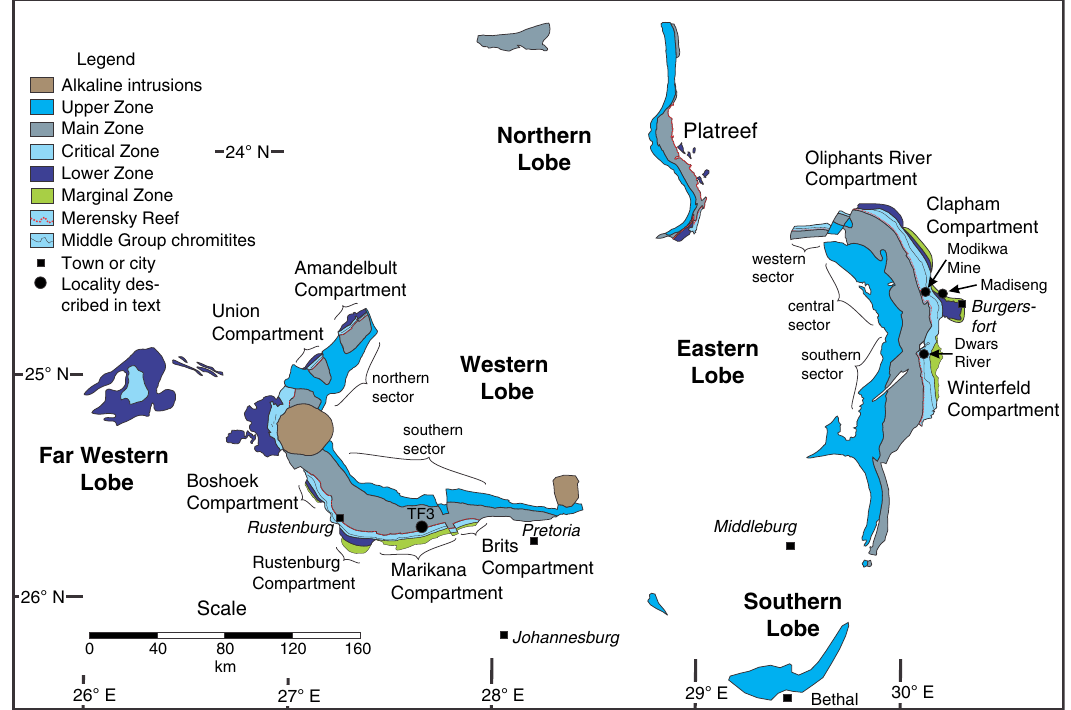
Figure 1 | Geological map of the Rustenburg Layered Suite of the Bushveld Complex. Compiled from multiple sources cited in the text 3,17,20–24,27 . Much of the Lower Critical Zone and all of the Lower Zone appear as discrete intrusions beneath the more continuous Upper Critical Zone and Main